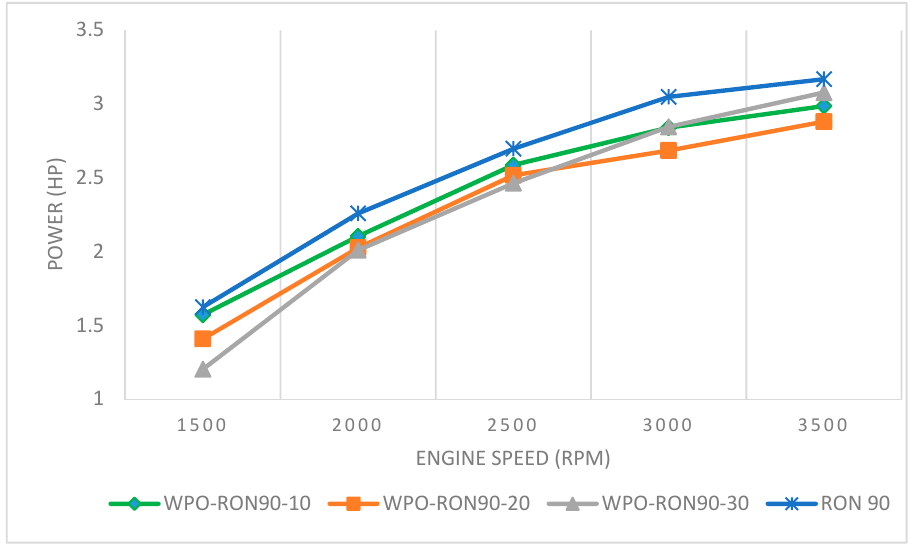
Figure 8. Effect of WPO-RON90 blends on engine power compared to RON90. Figure 8. E ff ect of WPO-RON90 blends on engine power compared to RON90.